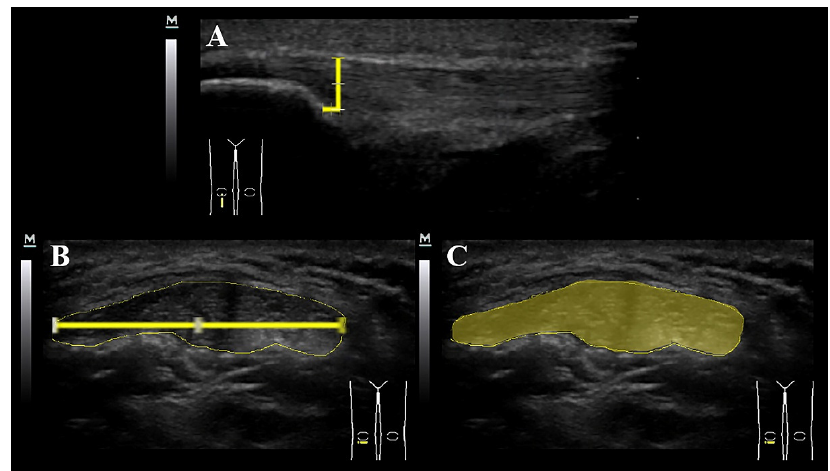
Figure 2. Ultrasound assessment of patellar tendon thickness ( A ), width ( B ) and cross-sectional area ( C ).